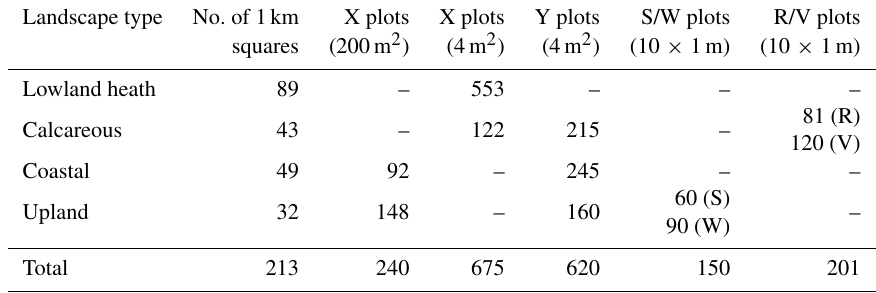
Table 6. Summary of vegetation plots